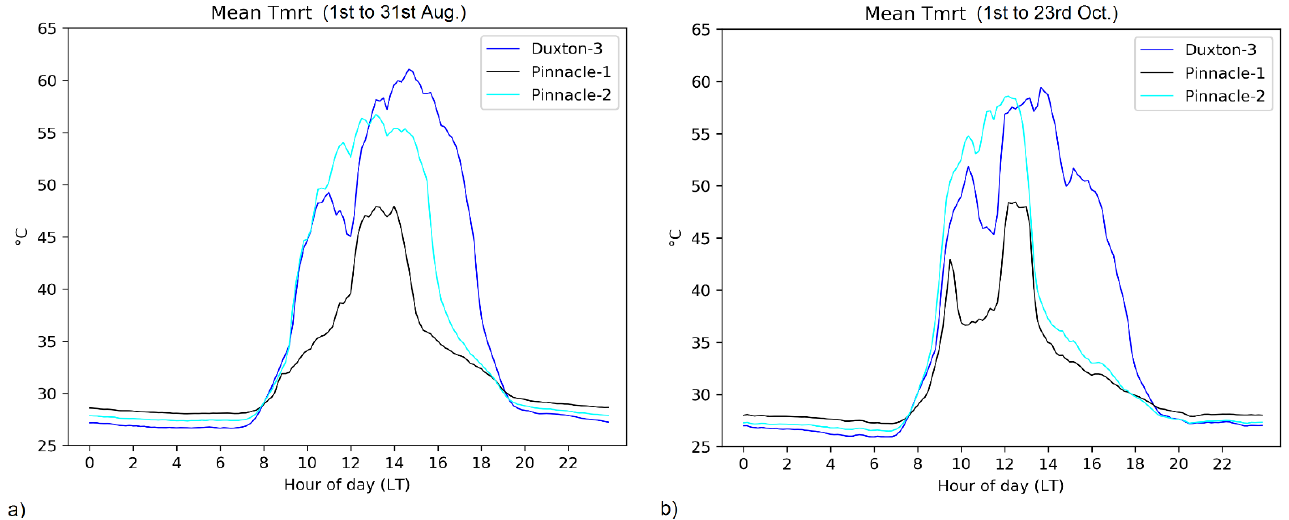
Figure 5. Mean T mrt diurnal cycle (using 10-min averaged values) in Pinnacle1, Pinnacle2, and Duxton3 in Duxton Park in two different seasons: ( a ) SW-Monsoon (1 to 31 August 2019) and ( b ) Inter-Monsoon (1 to 23 October 2019).